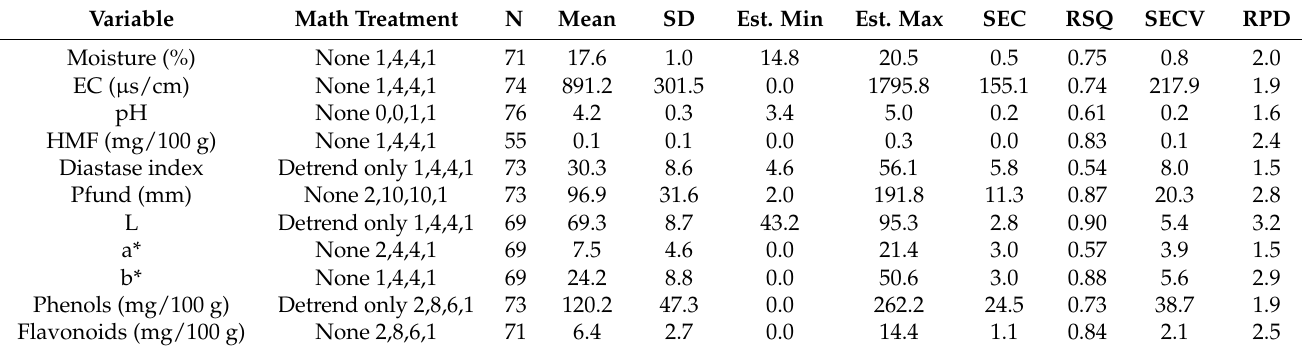
Table 2. Statistical descriptors of modified partial least squares (MPL)S calibration models for each physicochemical parameter. Variable Math